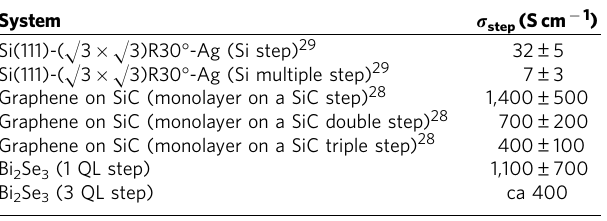
Table 1 | Step conductivity s step of different 2D systems measured by